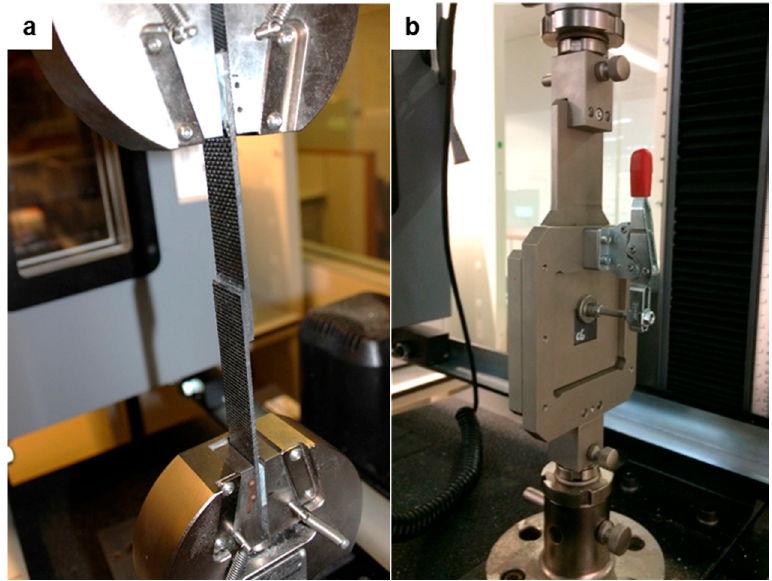
Figure 9. Tensile test setup for ( a ) single-lap shear specimen and ( b ) a block shear specimen.